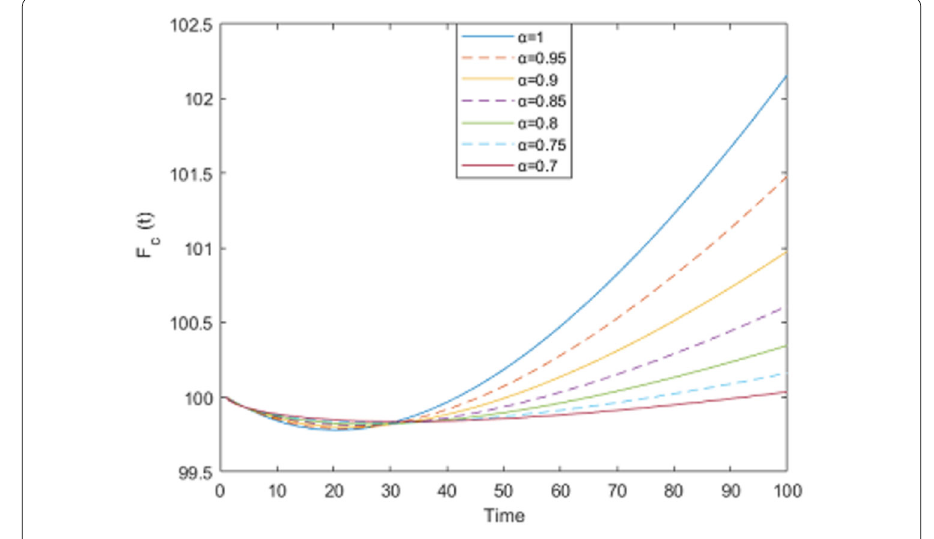
Figure 8 The class of susceptible